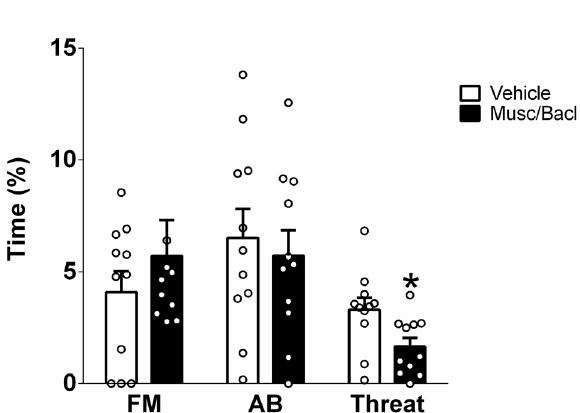
Fig. 5 Effects of pharmacological inhibition of the posterior agranular insular cortex (pAIC) on sexual aggression (SxA) indicated by the percentage time displaying forced mounting (FM), and on general aggressive behavior (AB) and threat. Adult male Wistar rats were bilaterally infused with a cocktail of 20 ng/ μ l muscimol and 200 ng/ μ l baclofen or vehicle into the pAIC 10 prior to exposure to the SxAT. Data are presented as mean + s.e.m.; * p <